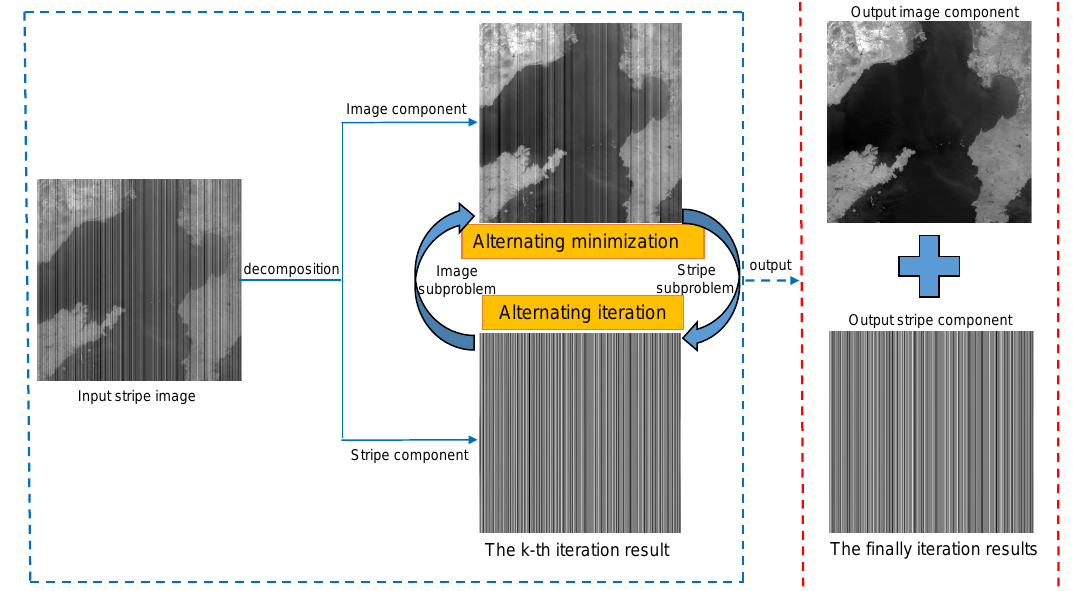
Figure 3. The framework of the proposed